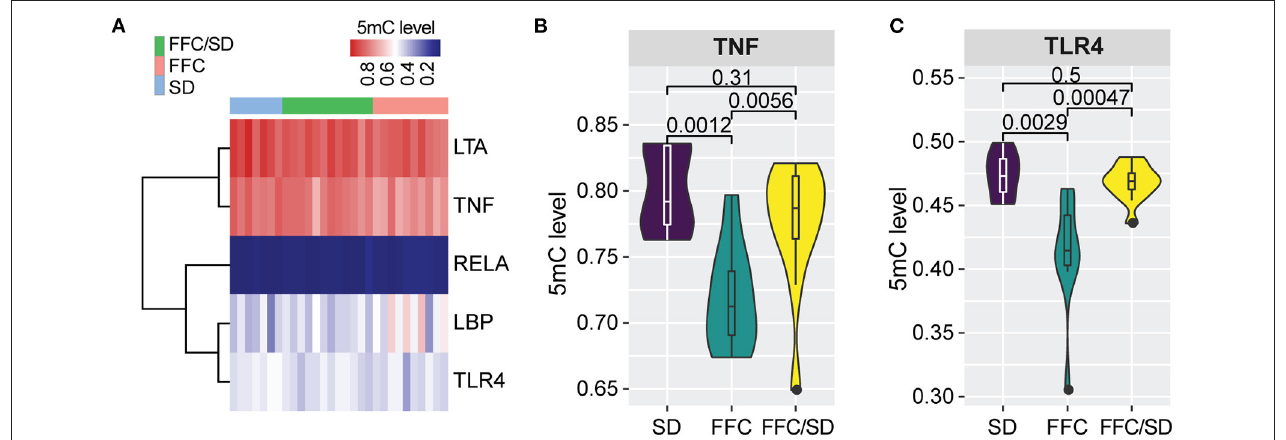
FIGURE 3 | Methylation changes associated with inflammation response. (A) Heatmap depicting the hierarchical clustering of methylation level of promoter regions of the five genes associated with inflammation response. (B,C) Boxplot of methylation level of promoter regions of TNF (B) and TLR4 (C) . P -values were calculated using Mann-Whitney U-